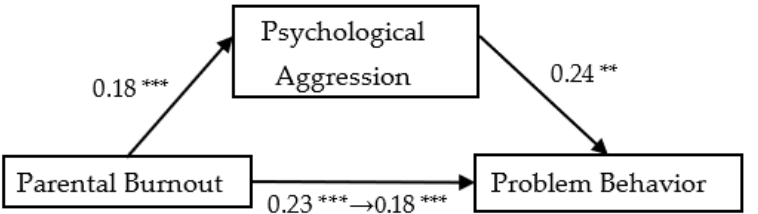
Figure 3. The mediating effect of psychological aggression on parental burnout and problem behavior. ** p < 0.01, *** p < 0.001.